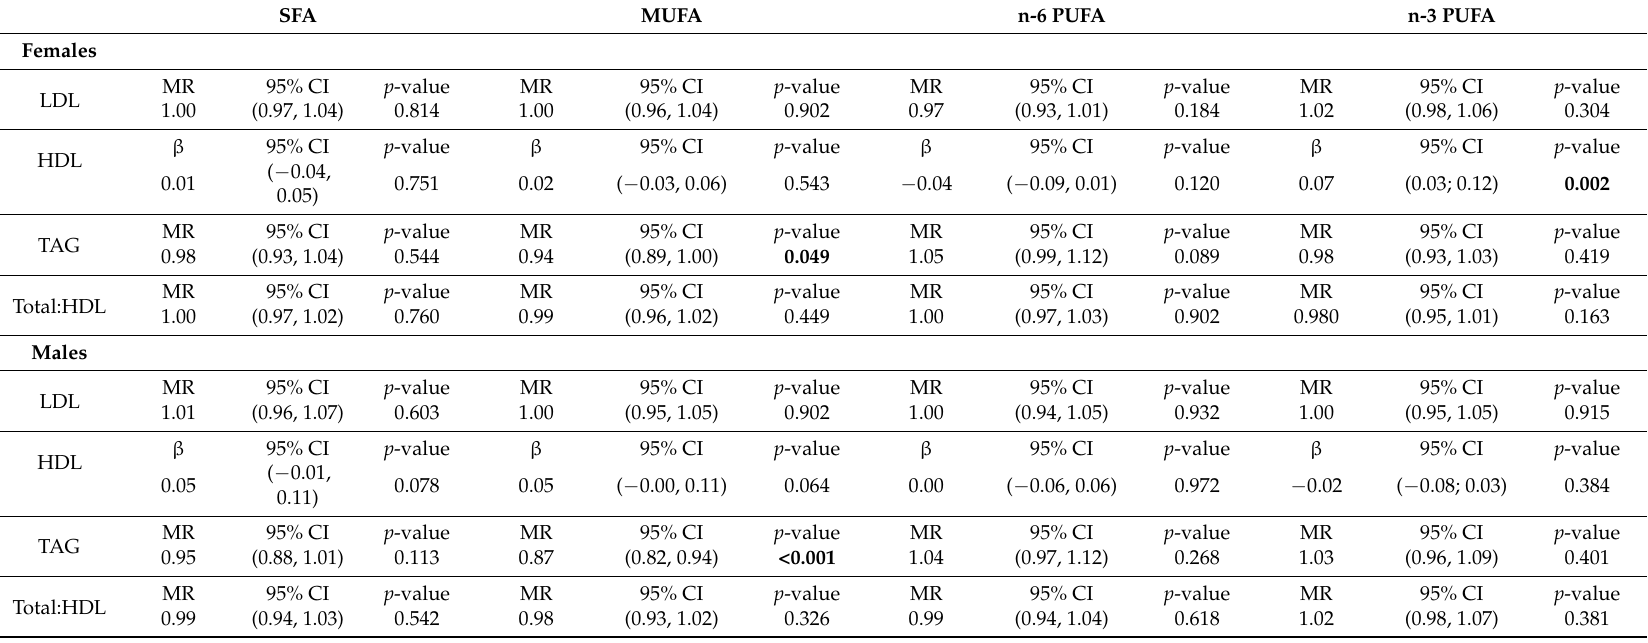
Table 2. Association of different types of fatty acids (when theoretically replacing dietary carbohydrates (CHO)) with blood lipid